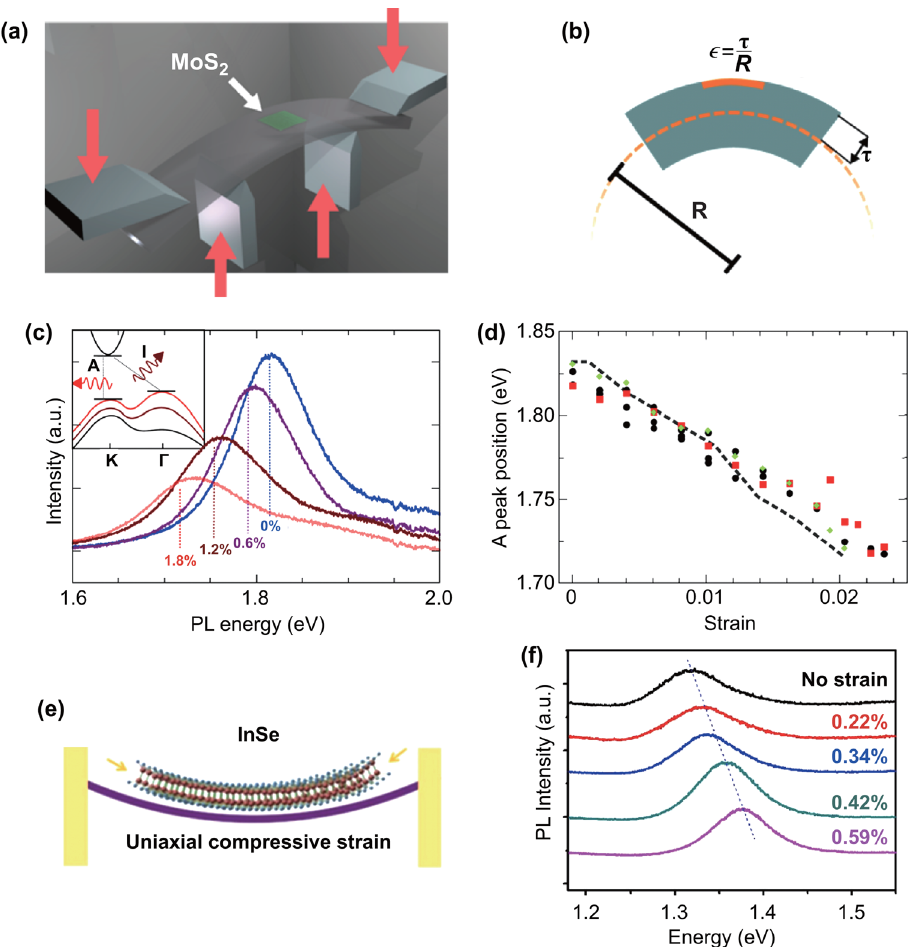
Fig. 7 Applied uniaxial strain to 2D semiconductors. a Schematic of applied bending strain on MoS 2 device and b the strain calculation method. c PL spectra of a representative monolayer device as it is strained from 0 to 1.8%. d Position of the PL peak as a function of strain. Reproduced with permission [40]. Copyright 2013, American Chemical Society. e A schematic of a two-point bending apparatus used for applying uniaxial compressive strain. f PL spectra of a multilayer InSe flake of thickness ~ 14 nm under different uniaxial compressive strains. Reproduced with permission [142]. Copyright 2018, IOP